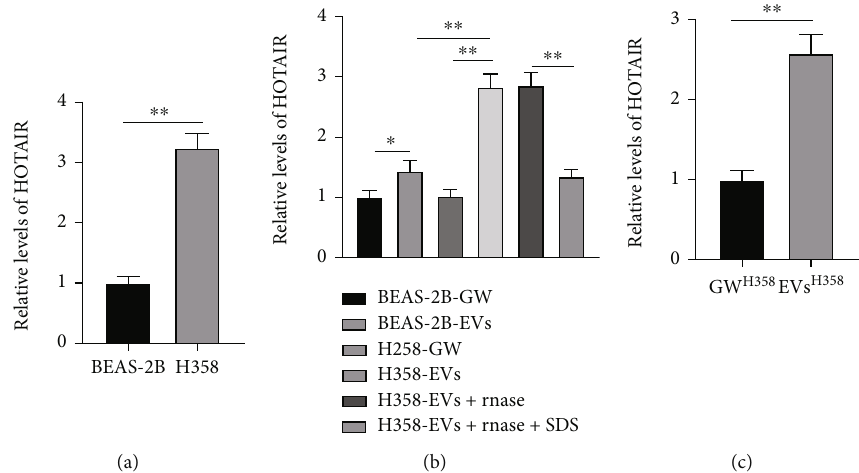
Figure 3: H358-EVs carried HOTAIR into NFs. RT-qPCR was adopted to detect the HOTAIR levels in H358 and BEAS-2B cells. (a) H358- EVs treated with Rnase and SDS. (b) H358-EVs (50 μ g) cocultured with NFs for 6 hours. (c) Cell experiment was repeated three times. The t -test was used for data comparison between groups in Figures (a) – (c), one-way ANOVA was used for data comparison among multiple groups in Figure (b), and Tukey ’ s test was used for the post hoc test. ∗∗ P < 0 : 01